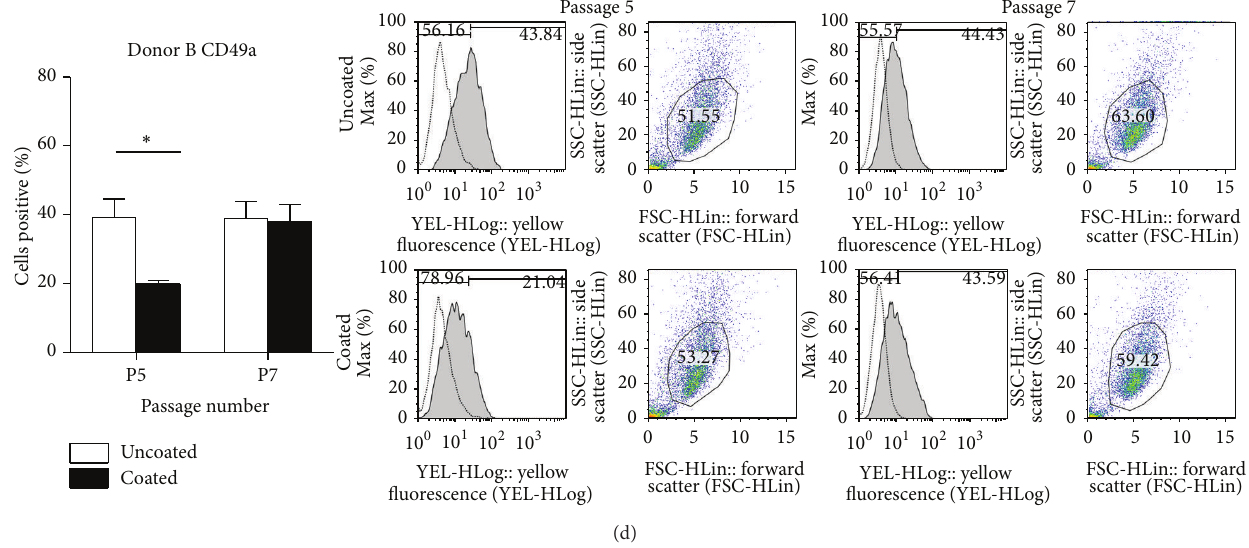
Figure 4: Flow cytometry analysis of stem cell marker expression. Human MSCs from Donor A and Donor B were cultured on uncoated or keratin-coated surfaces from passage 4 to passage 7. The stem cell markers STRO-1 (a and b) and CD49a (c and d) were assessed at passage 5 and passage 7. All plots show relative percentage expression levels. Representative scatter plots (FSC, 𝑥 -axis and SSC, 𝑦 -axis) show gating of live cells, while histograms show the distribution of expression of the surface markers; 𝑛 = 3 , ∗ 𝑃 < 0.05